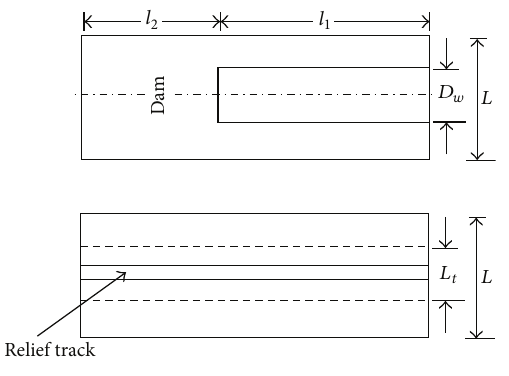
Figure 2: Pressure dam geometry.